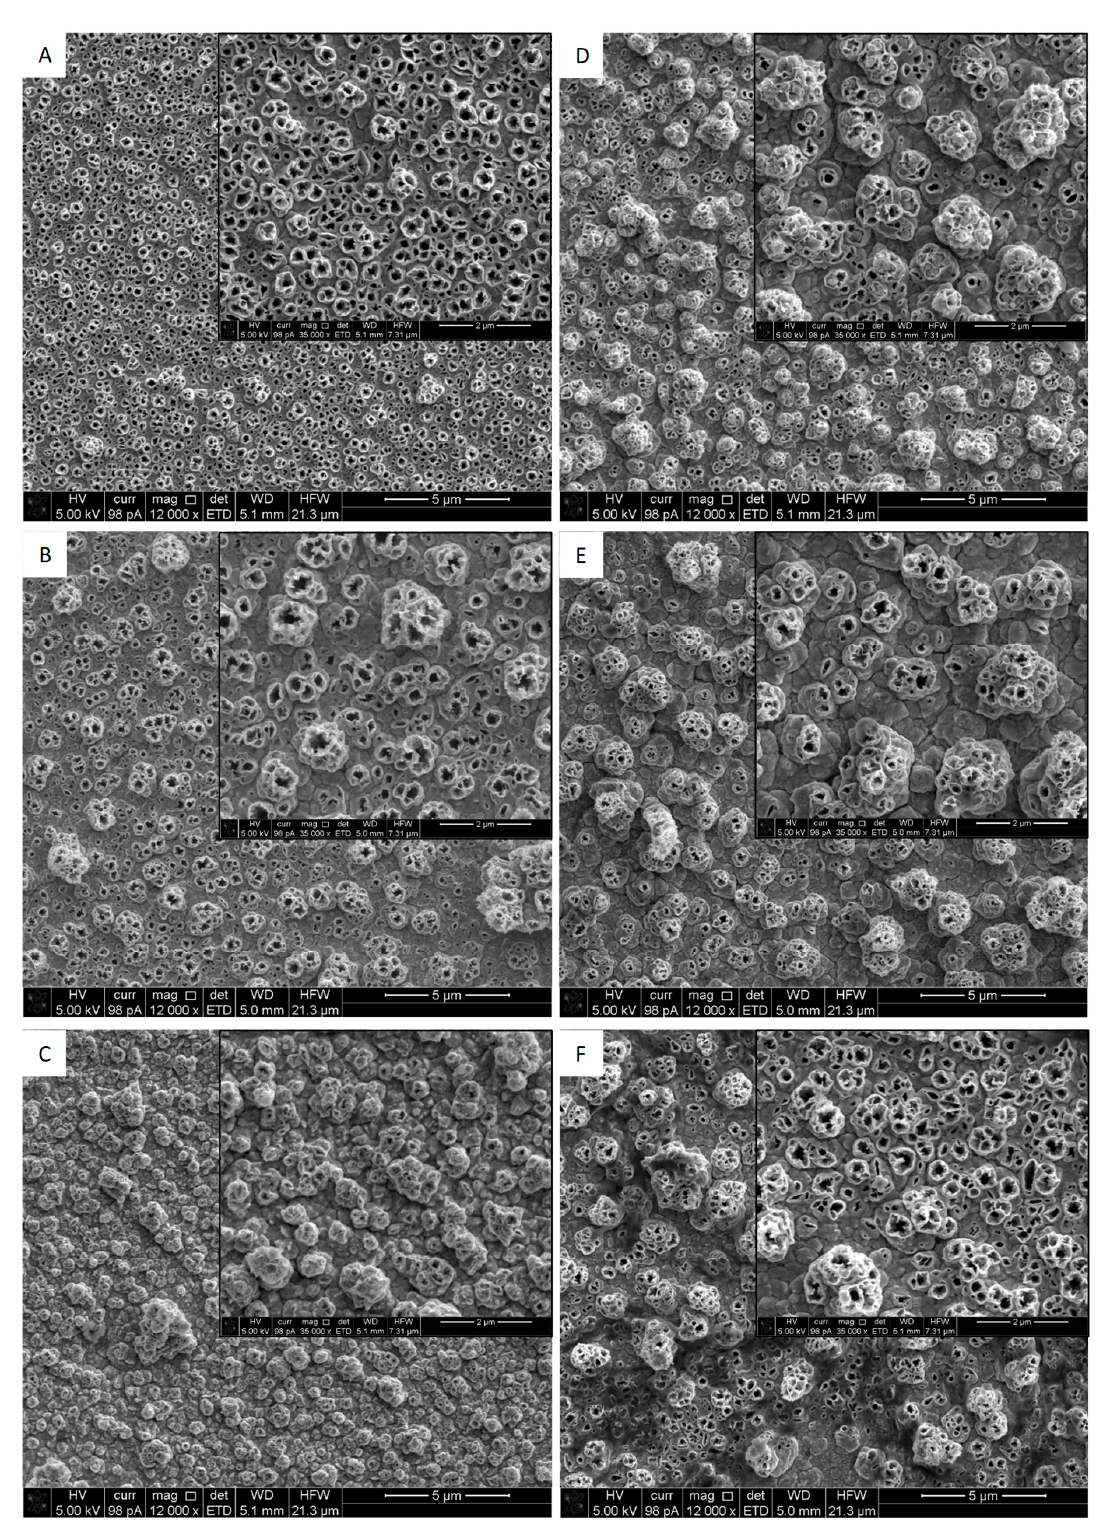
Figure 2. SEM images of samples submitted to different conditions of anodic dissolution: ( A ) S 1–5 ; ( B ) S 0.1–0.5 ; ( C ) S 0.01–0.05 ; ( D ) S 1–50 ; ( E ) S 0.1–5 ; ( F ) S 0.01–0.5 . Insets report the magnifications of the SEM images of the samples.